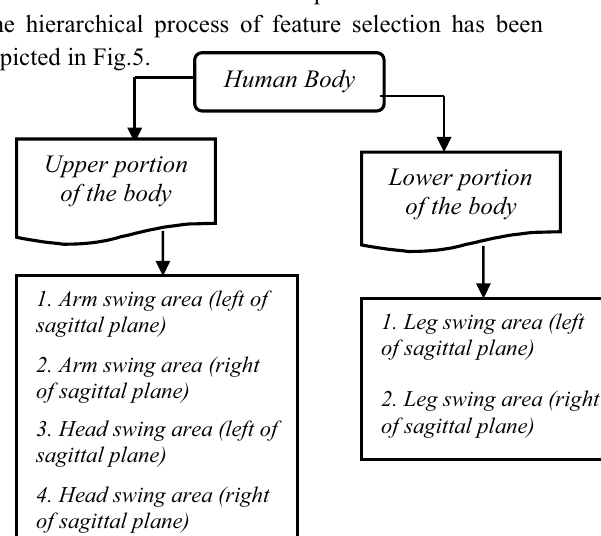
Fig. 5. Hierarchical process of feature